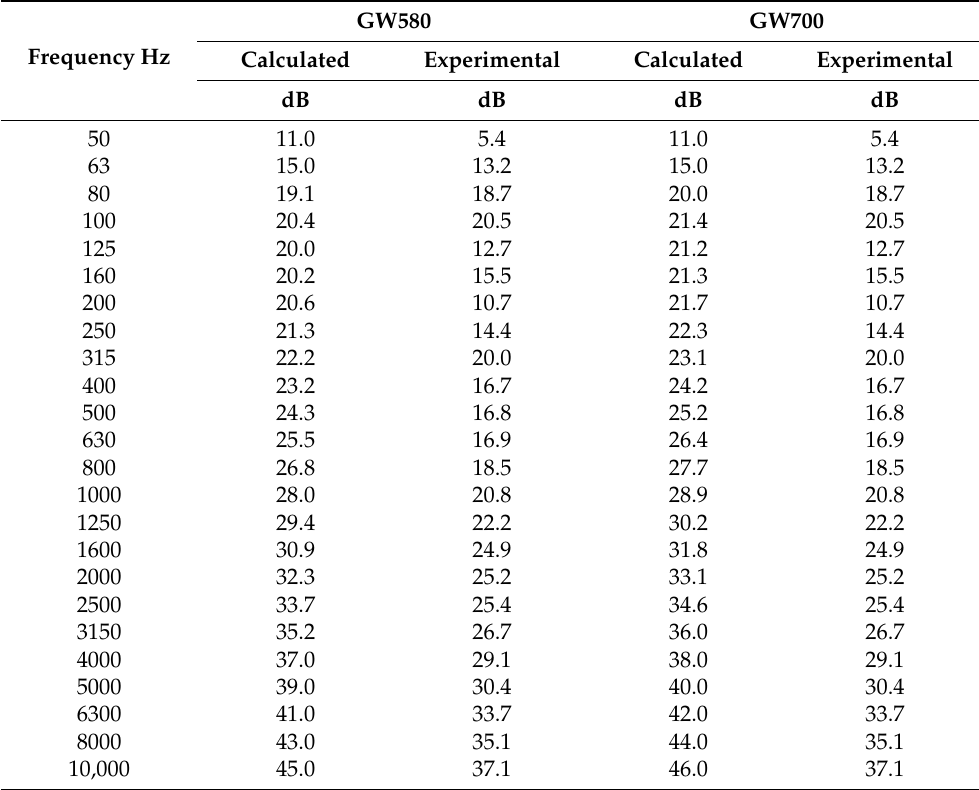
Table 4. Measured and predicted transmission loss for GW580 and GW700 PVC panels.